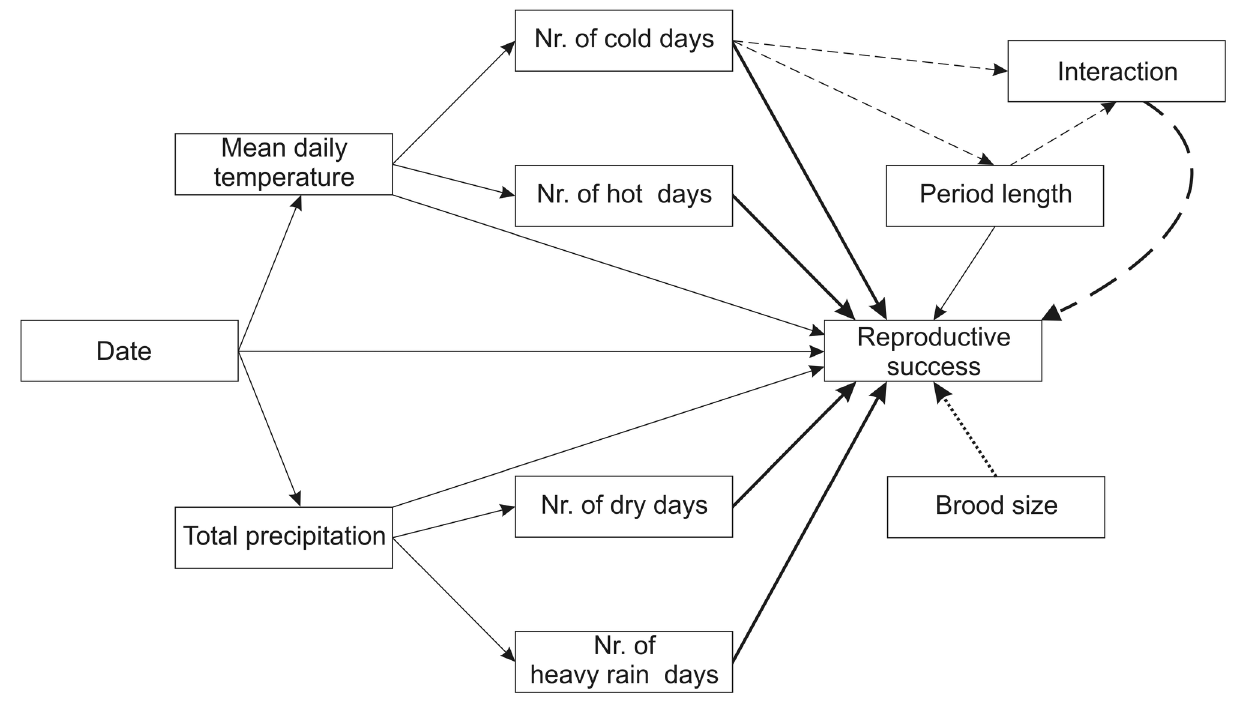
Figure 1. Model structure in SEM analyses. Thin lines stand for effects included in all models, thick lines for relationships that varied within model sets, dashed lines for paths contained only in the model set of hatching success, and the dotted line for the effect of brood size in model sets of nestlings’ body mass and tarsus